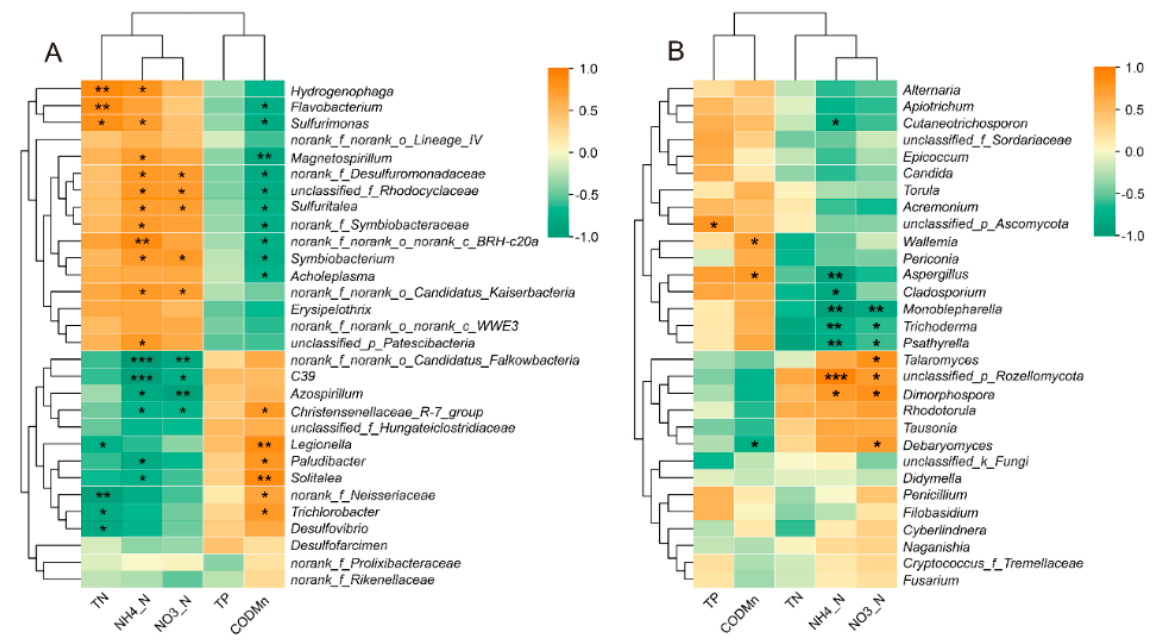
Figure 7. Correlation heatmap of bacteria ( A ) and fungi ( B ) taxa in control and melatonin after treatment for 7 days with the wastewater TN, TP, NH 4+ -N, NO 3 − -N, and CODMn, chemical oxygen demand. TN, total nitrogen; TP, total phosphorus; NH 4+ -N, ammonium nitrogen; NO 3 − -N, nitrate nitrogen. “*” indicates significance at p < 0.05, “**” indicates significance at p < 0.01, and “***” indicates significance at p < 0.001.